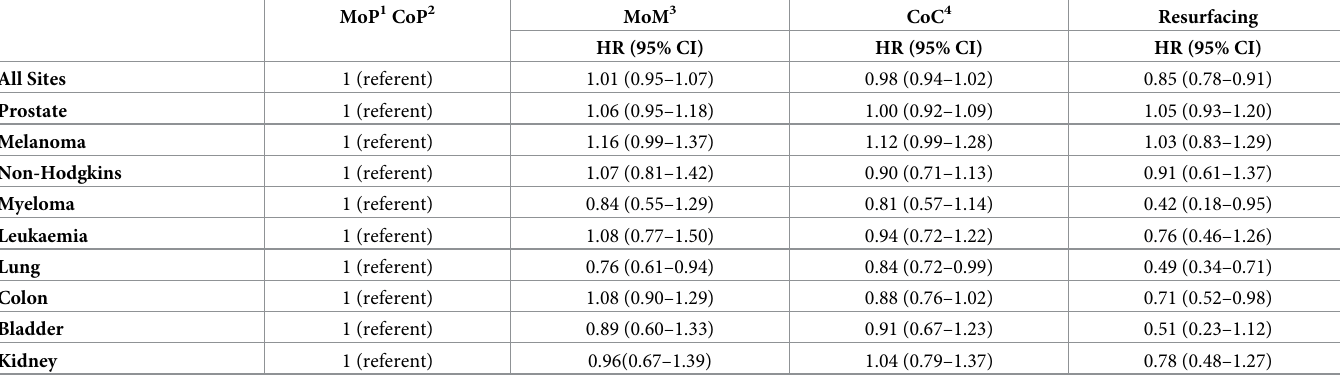
Table 3. Risk of cancer incidence for all-cause and site-specific cancers by bearing